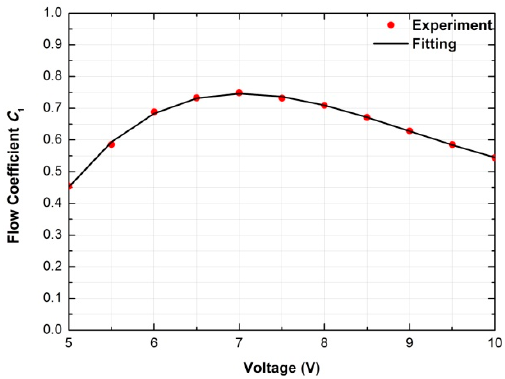
Figure 11. Curve of the flow coefficient C 1 under different driving